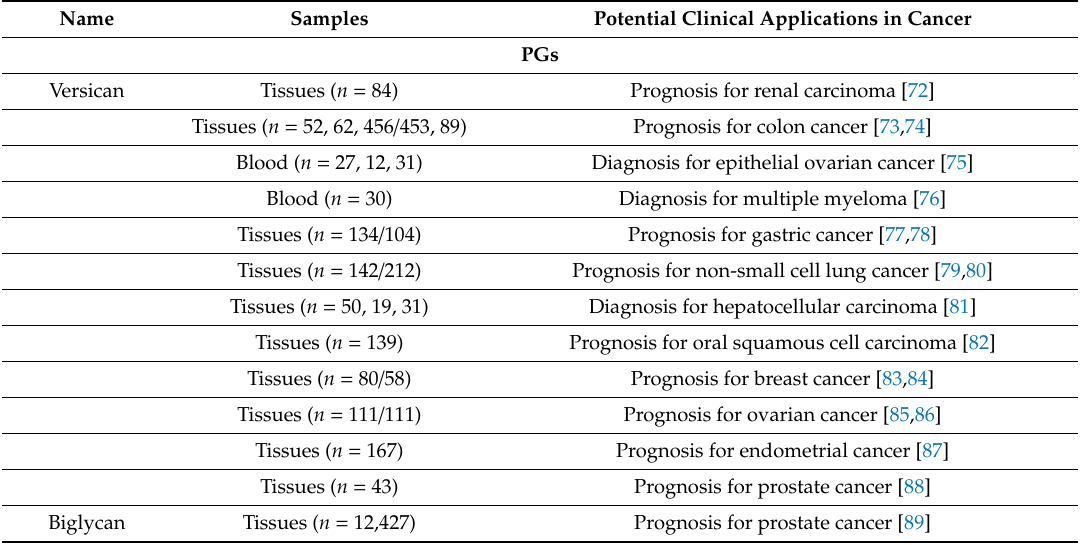
Table 2. The values of PGs / GAGs and related enzymes in pre-clinical and clinical studies of